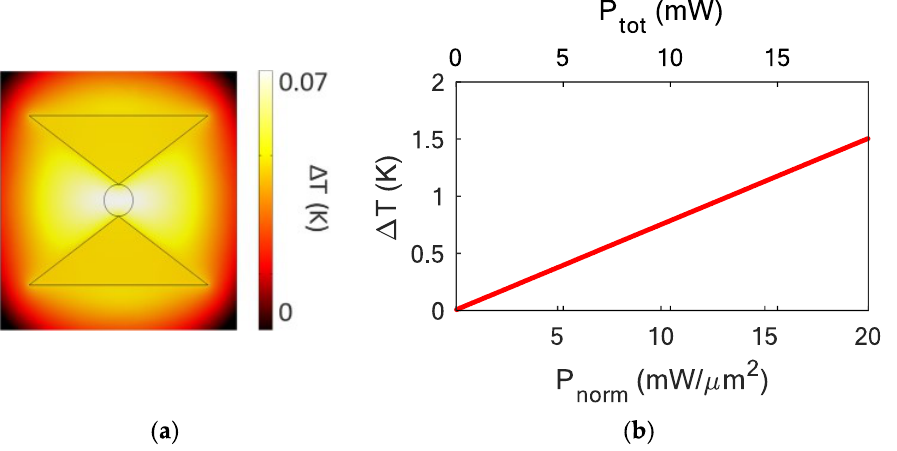
Figure 3. ( a ) Top view of the temperature distribution ∆ T (K) ( ∆ T = T − T 0 , T 0 = 293.15 K) for the designed configuration at z = 110 nm, with P norm = 1 mW/ µ m 2 ; ( b ) temperature increase ∆ T in the trapping region as a function of the normalized input optical power P norm and then P tot ( A = 0.96 µ m 2